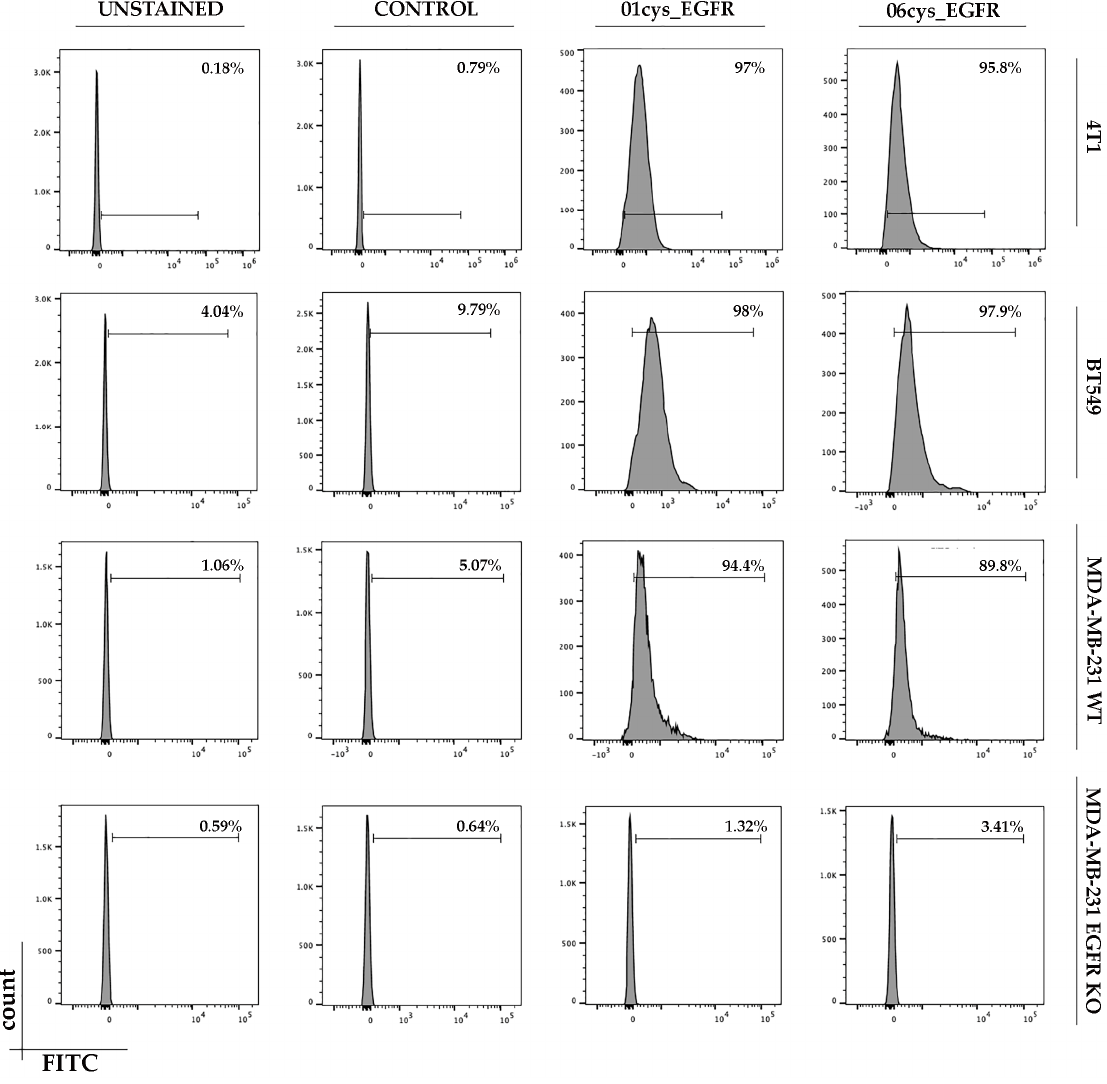
Figure 5. Binding assay of peptides to TNBC cells. Cells were incubated with 01cys_EGFR, 06cys_EGFR peptides, or the irrelevant peptide as control and then analyzed by flow cytometry. Percentage of binding efficiency of peptides is shown in each panel. The TNBC cell lines were: MDA- MB-231, BT-549, and 4T1. The cell line MDA-MB-231 EGFR-KO was included as a negative control.